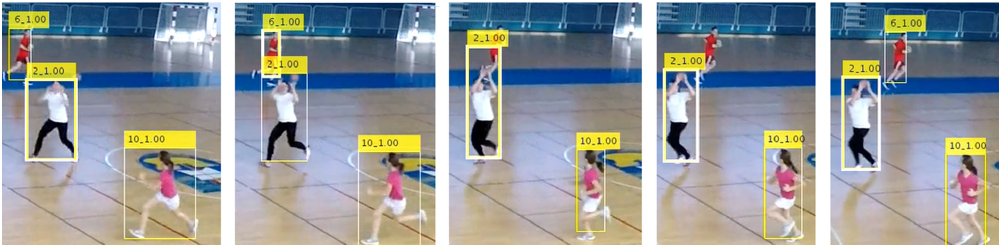
Figure 4. Player tracking across frames.